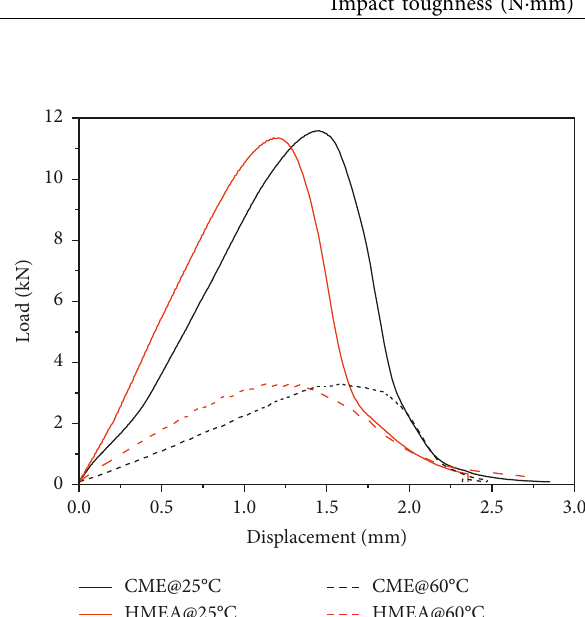
Figure 10: Load versus displacement curves of